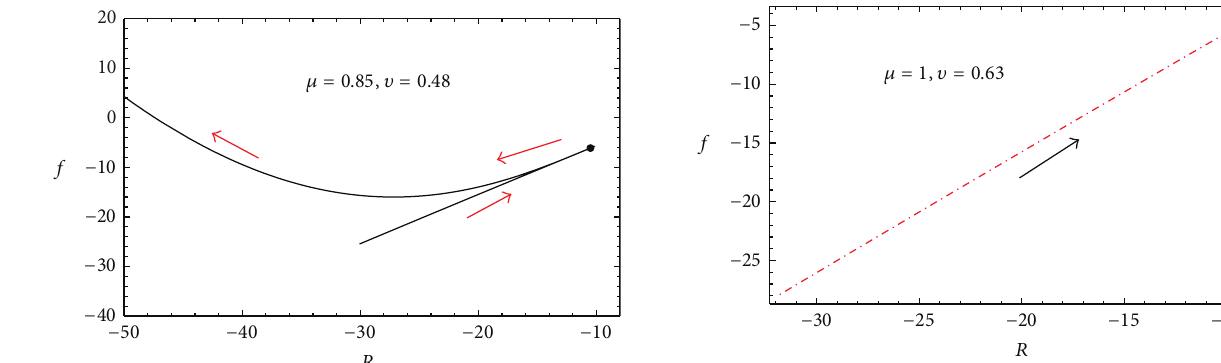
Figure 12: Future evolution of 𝑓(𝑅) for (𝜇,𝜐) = (0.85, 0.48) with −1 ≲ 𝑧 ⩽ 2 . The dot denotes the present day and is the point of reversion for DE dominated model.